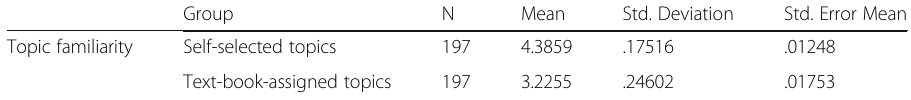
Table 11 The Mean Values of the Learner ’ s Perception of the Textbook-Assigned Topics and Self- Selected Topics Regarding the Topic of Familiarity Group